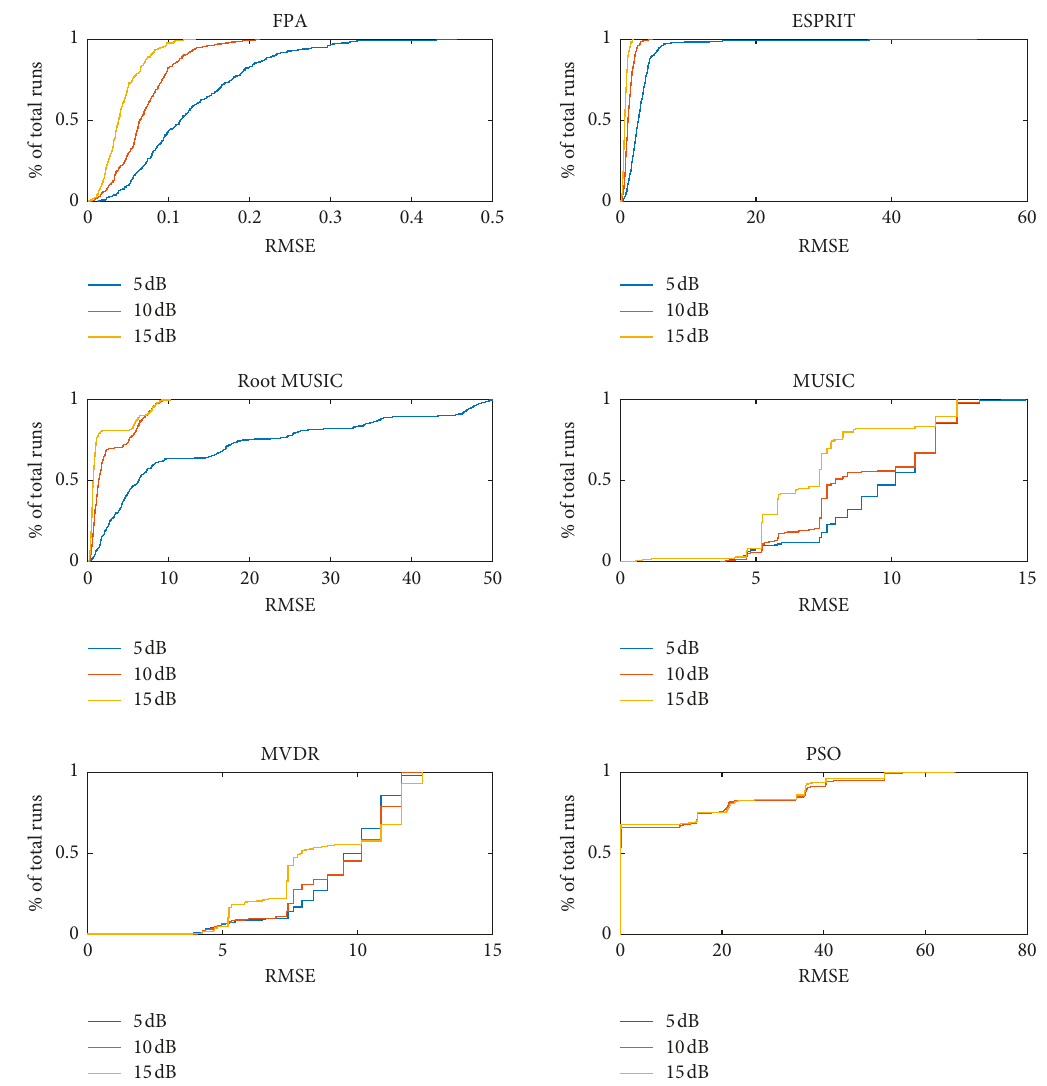
Figure 16: CDF of RMSE for three